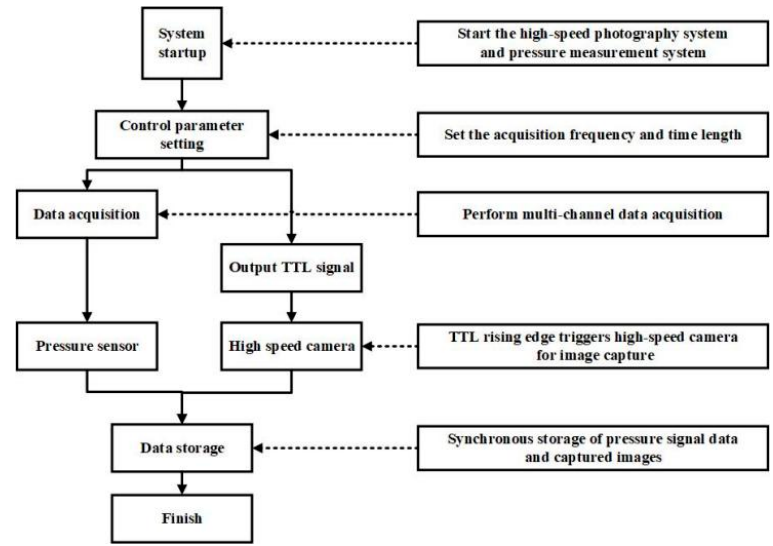
Figure 3. Operation flow chart of this experiment.